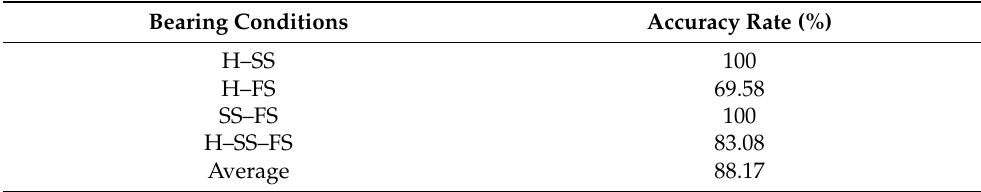
Figure 10. Loss of the proposed system. Table 1. Diagnosis results for basic scratch